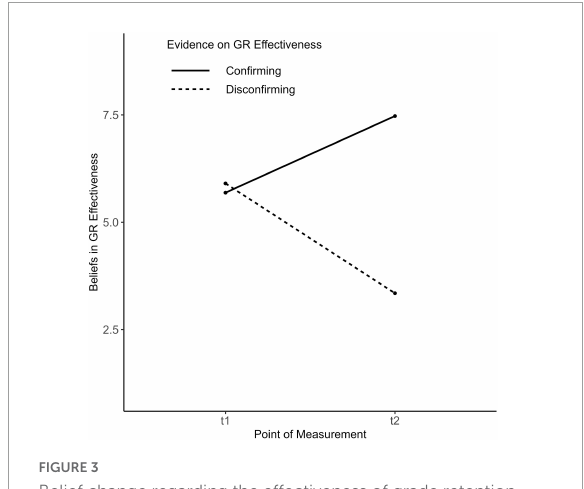
FIGURE3 Belief change regarding the effectiveness of grade retention (Study